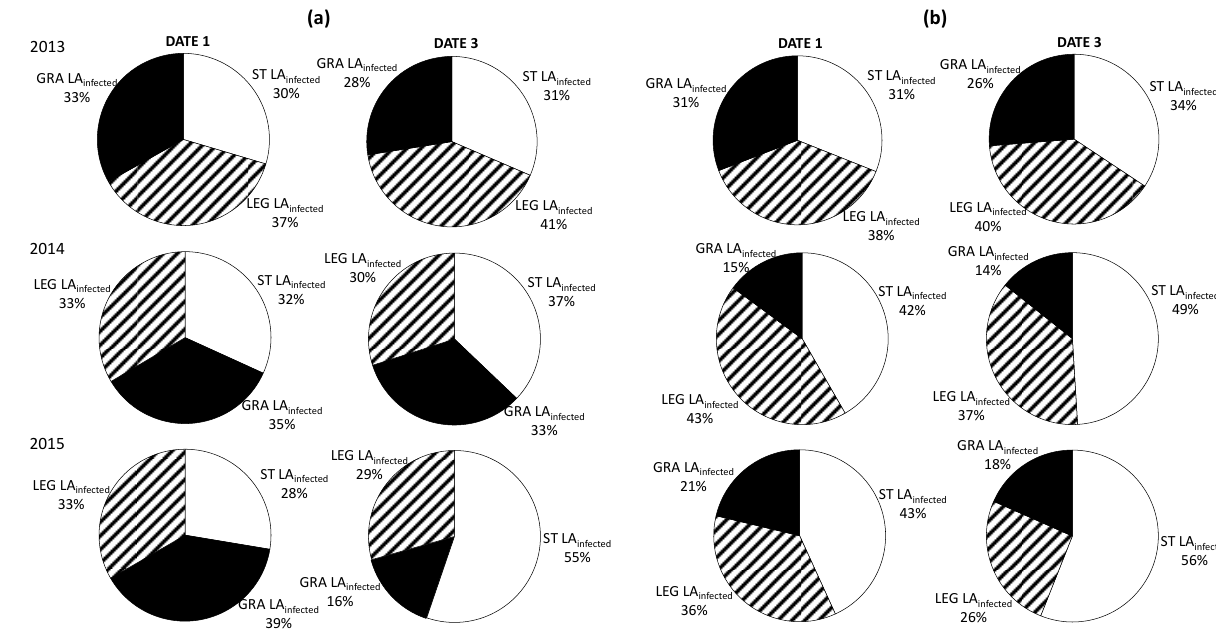
Figure 5. Proportion of total downy mildew-infected ( a ) and powdery mildew-infected ( b ) LA per shoot detected in the cover crop and soil tillage treatments (respectively, GRA, LEG, and ST LA infected ) on disease field monitoring dates 1 and 3, in the three study seasons.